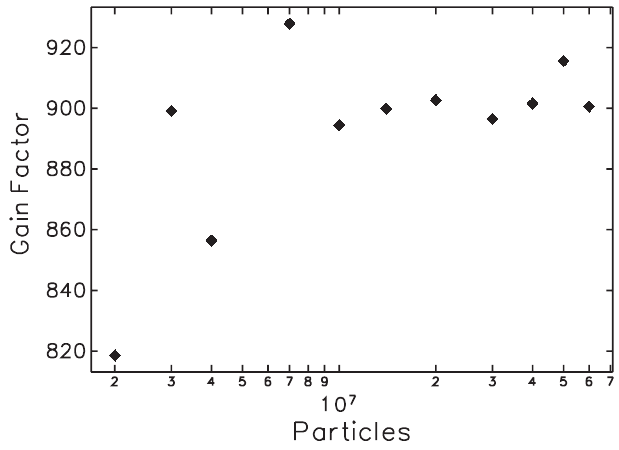
FIG. 11. Dependence of the computed gain on the number of particles for an initial modulation of 0.05% at 30 (cid:1) m .